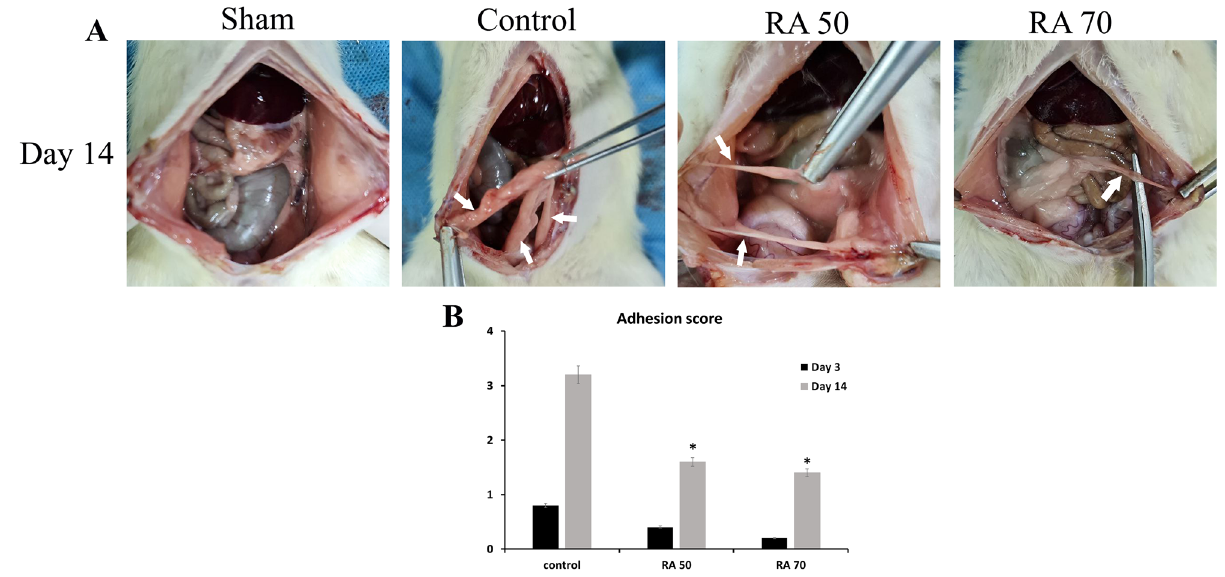
Figure 1. Macroscopic evaluation of adhesion bands in different experimental groups of the study on day 14. ( A ) The diagram shows the adhesion score by the method of Nair et al. ( B ) * indicates a significant difference with the control